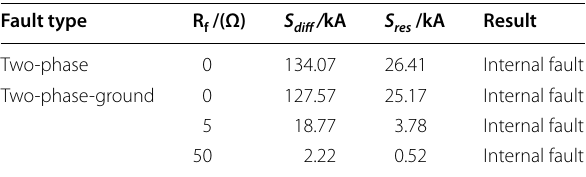
Table 2 Simulation results of N occur at f 3